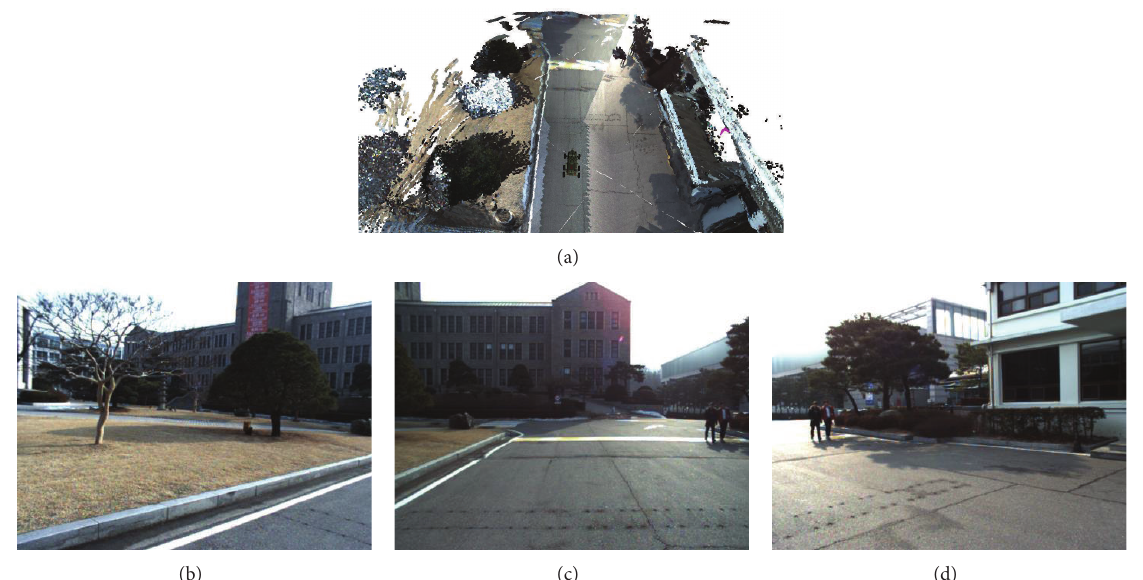
Figure 3: A terrain reconstruction model. (a) Nonground objects and ground surface representation. (b)–(d) Captured images.